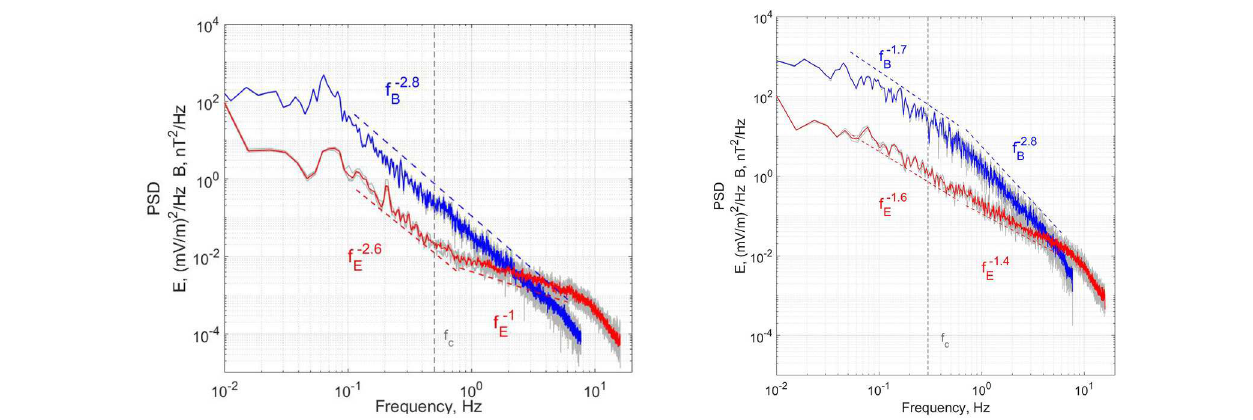
FIGURE 5 | (Left) PSD of the average over the four MMS spacecraft magnitudes of the electric (red) and magnetic (blue) fields over-plotted on the spectrum from each spacecraft (gray) for the Q ⊥ MSH; (Right) Same as on the left in the Q || MSH. The vertical gray dashed line marks the respective gyrofrequency f c for each MSH geometry. The error in the spectral slopes are very small and are reported in the